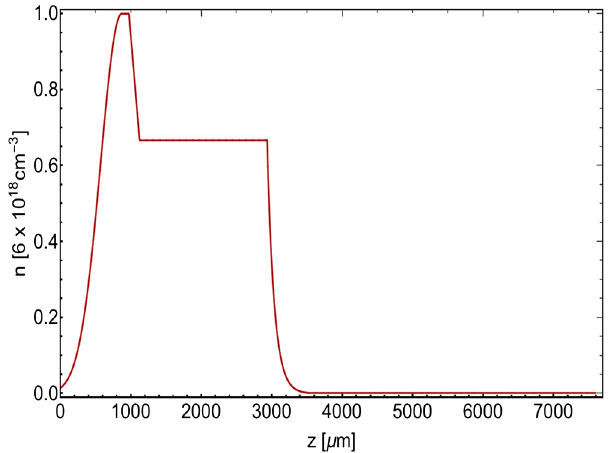
FIG. 5. The longitudinal density profile used for the down-ramp injection scheme [32].